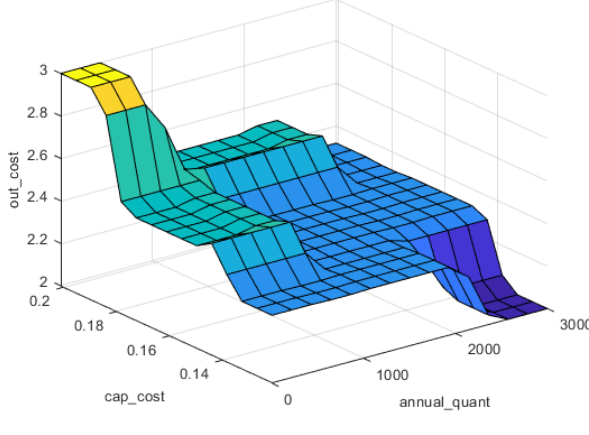
Figure 7. Comparison of recycling and landfilling cost (EUR/kg) generated by developed system.